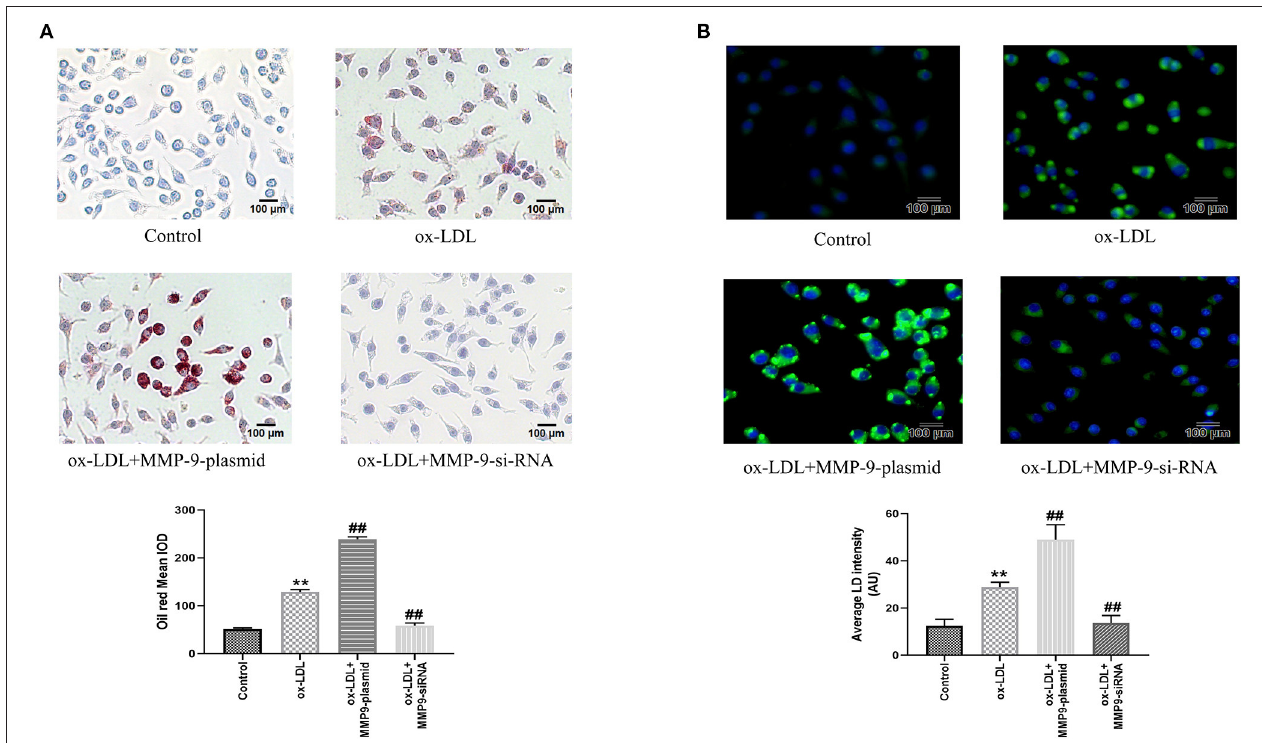
FIGURE 4 | Oil Red O and BODIPY 493/503 staining after MMP-9-plasmid and MMP-9-siRNA transfections. (A) THP-1 macrophage cells were transfected before incubation with ox-LDL for 24h and stained with Oil Red O ( × 200, 100 µ m), the intracellular lipid droplets of the mean optical density value (mean IOD) were used to reflect the degree of cellular foam. (B) Lipid droplets were labeled with green fluorescence and the nuclei were labeled with DAPI (blue) ( × 200, 200 µ m), average LD intensity was used to quantify lipid uptake. Data are presented as the mean ± SD, n = 6. Compared with the control group, ** P < 0.01; compared with the ox-LDL group, ## p <